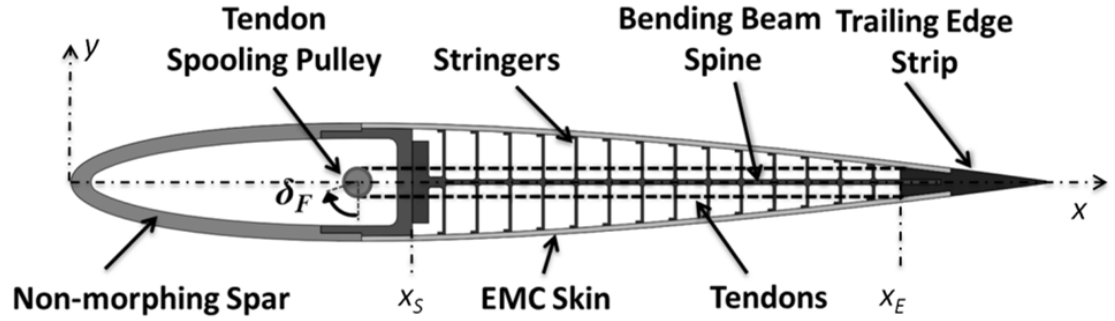
Figure 2. The fish bone active camber (FishBAC) concept.